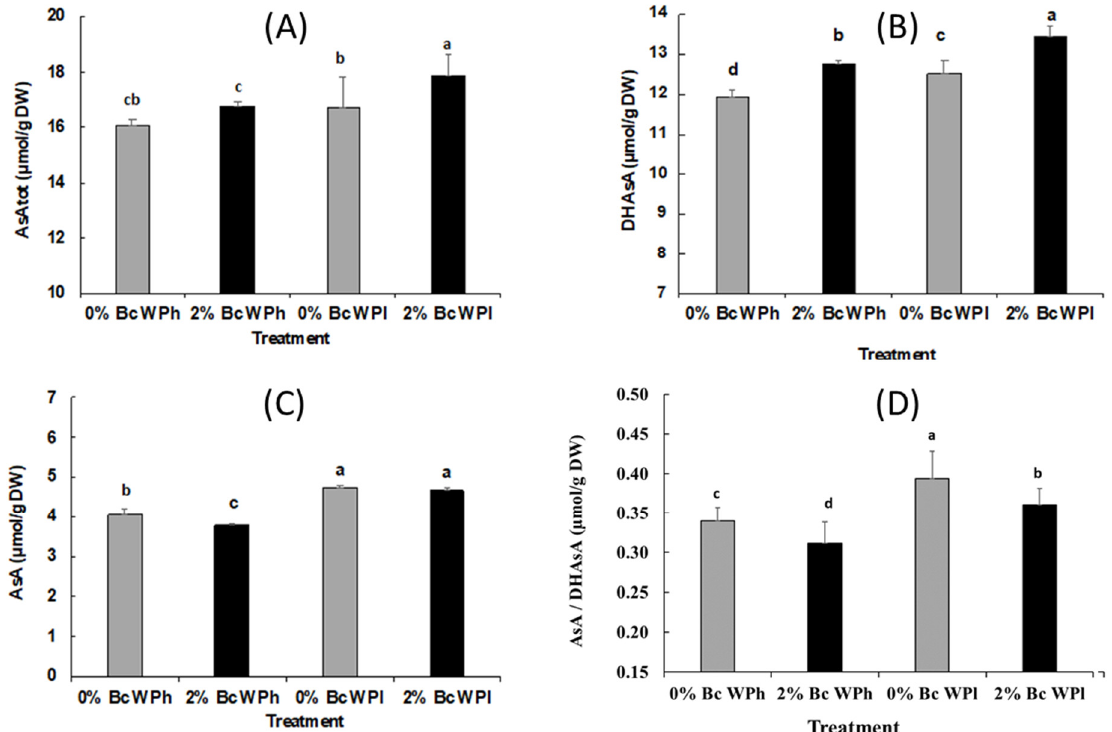
Figure 8. The content of total ascorbate (AsA + DHAsA) ( A ), AsA, ( B ), DHAsA ( C ), and AsA/DHAsA ratio ( D ) in Medicago ciliaris leaves after 3 weeks of drought treatment. Values represent mean ± SE ( n = 5) and the different letters a to d indicate significant differences between the treatments. Low soil water potential (WPl), high soil water potential (WPh), Biochar (Bc).